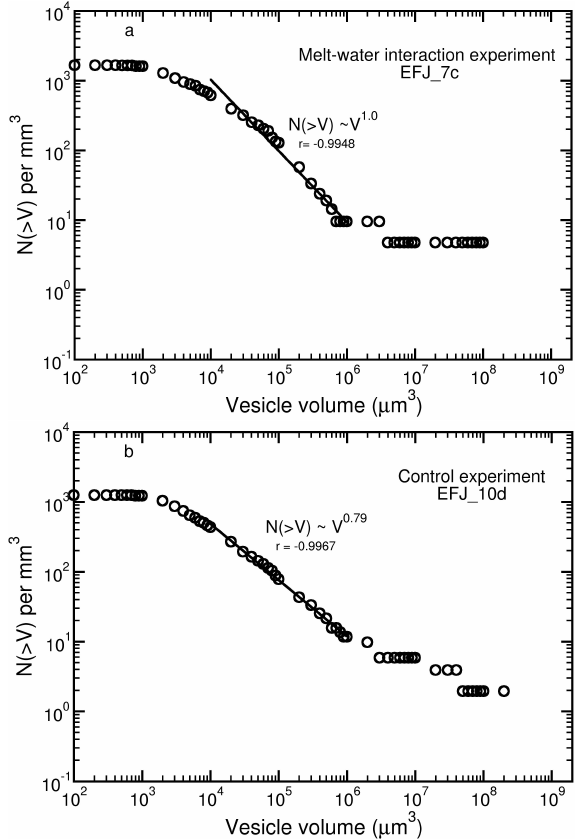
Fig. 3. Examples of cumulative vesicle size distributions in experi- mental run products. (a) Melt–water interaction experiment EFJ_7c with an initial water content of 2wt%, vesicularity of 54.5% and a VND of 1649 per mm 3 . (b) Control experiment EFJ_10d with an initial water content of 2.7wt%, vesicularity of 57.8% and a VND of 1246 per mm 3 . Note the similarity of the VSDs for the water in- undation (a) and control (b) experiments, leading to the conclusion that the VSDs in the natural samples (Fig. 2) are controlled by the exsolution of magmatic volatiles and can be compared to measure- ments of VSDs at Stromboli volcano, Italy. In each panel the open circles in each figure are the cumulative vesicle volume distribu- tions per mm 3 , and the lines are power-law fits (using the software package Grace) to vesicle volumes between approximately ∼ 10 4 and 10 5 µm 3 . All other experimental cumulative vesicle size distri- butions can be found in the